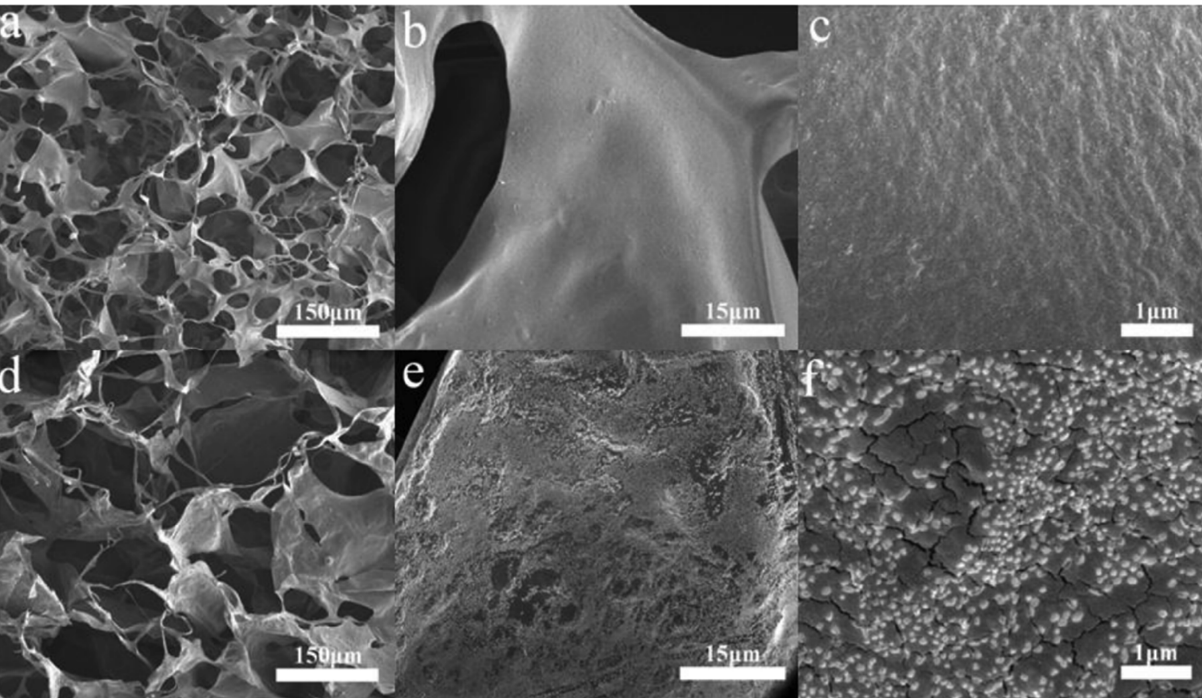
Figure 8. SEM images of the as-prepared SA aerogel ( a – c ) and SAT aerogel ( d – f ) with different magnifications. Reprinted from Reference [35].